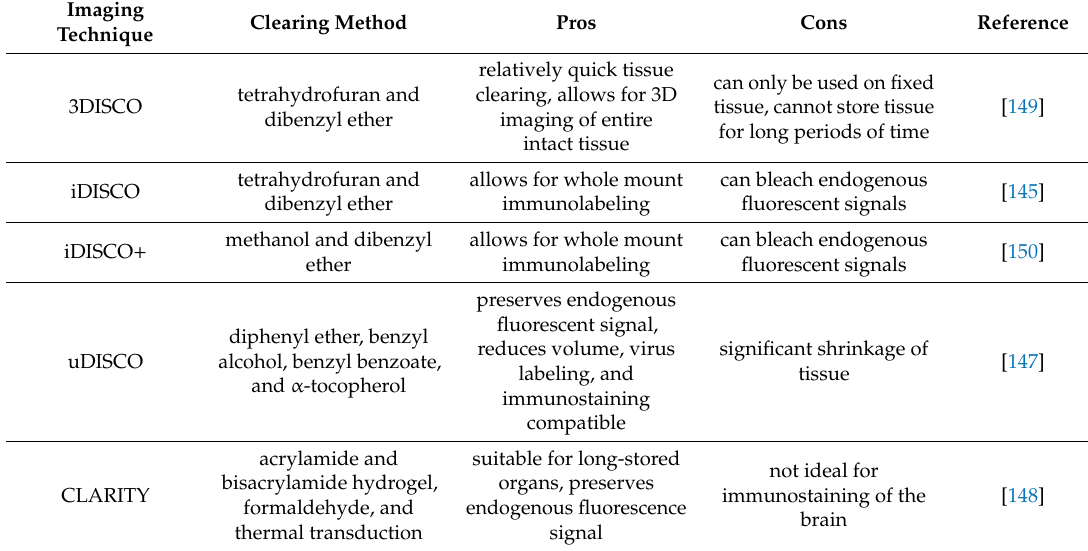
Table 1. Three-dimensional (3D) imaging techniques. 3DISCO: 3D imaging of tetrahydrofuran (THF) clearedorgans, iDISCO:immunolabeling-enabledDISCO,uDISCO:‘ultimate’DISCO,CLARITY:cleared lipid-extracted acryl-hybridized rigid immunostaining / in situ hybridization-compatible tissue